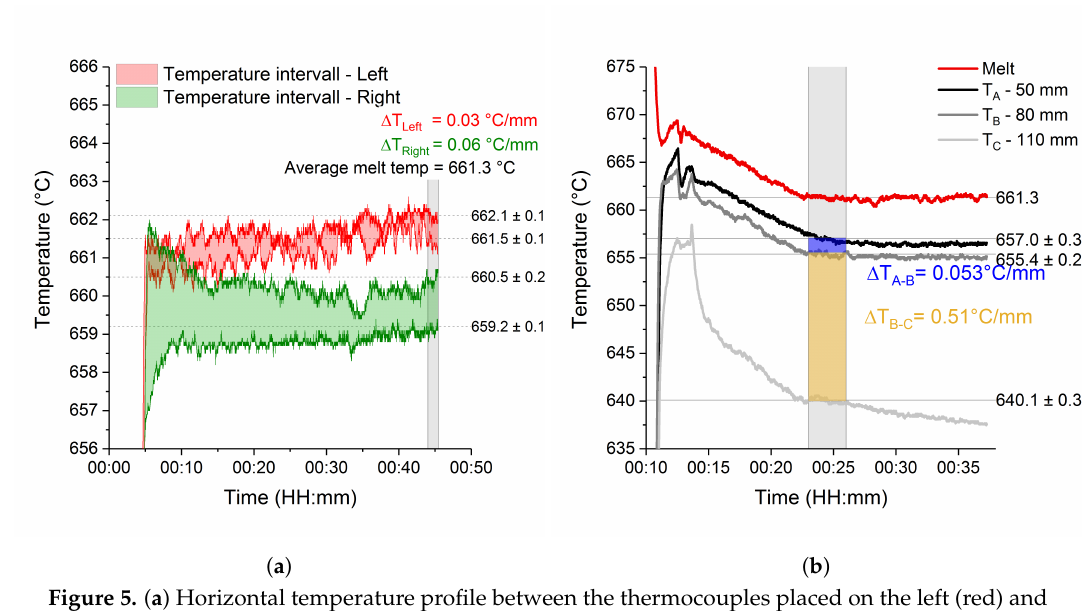
Figure 5. ( a ) Horizontal temperature profile between the thermocouples placed on the left (red) and right (green) side of the cooled finger and ( b ) Vertical temperature profile between the thermocouples placed inside of the cooled finger graphite